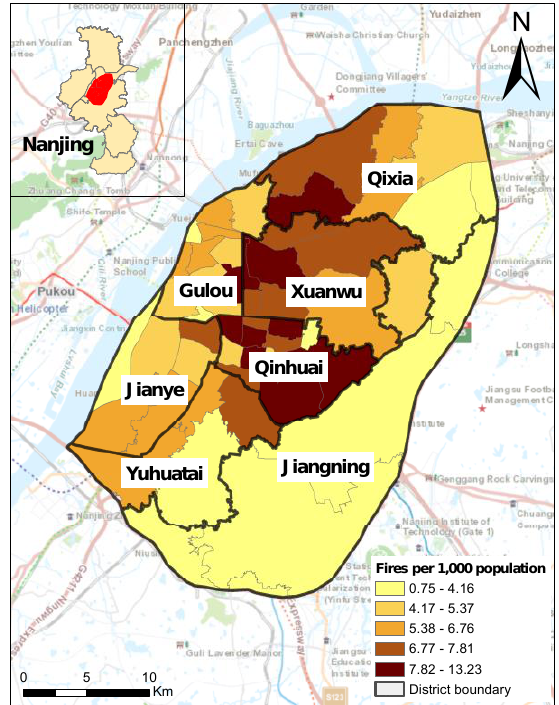
Figure 1. Fire incident rates for